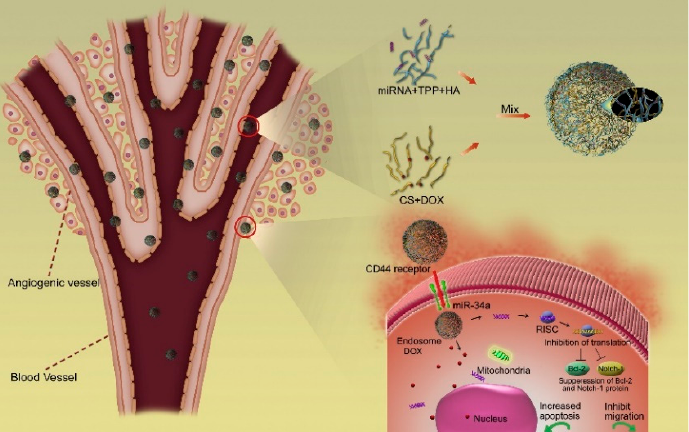
Figure 2. Schematic representation of HA-SANPs obtained from electrostatic interactions between HA and CS for DOX and miR-34a co-delivery. Reprinted with permission from Ref. [50]. 2014, Elsevier Ltd.